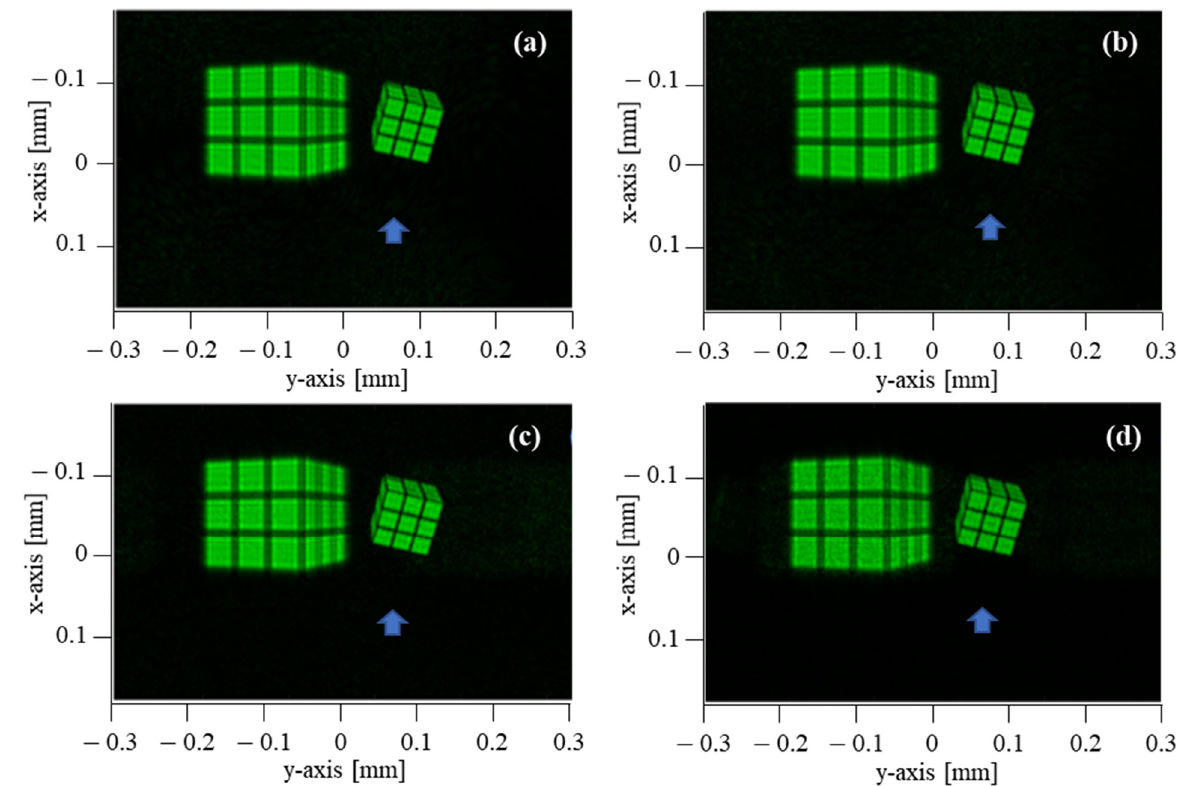
Figure 8. Numerical observations using holograms in the case of CAO encoding ( a ), MAO encoding ( b ), Burckhardt’s encoding ( c ), and Lee’s encoding ( d ) where the left eye of the observer is focused on the back-positioned 3D cube. The object focused is indicated by a blue arrow mark.